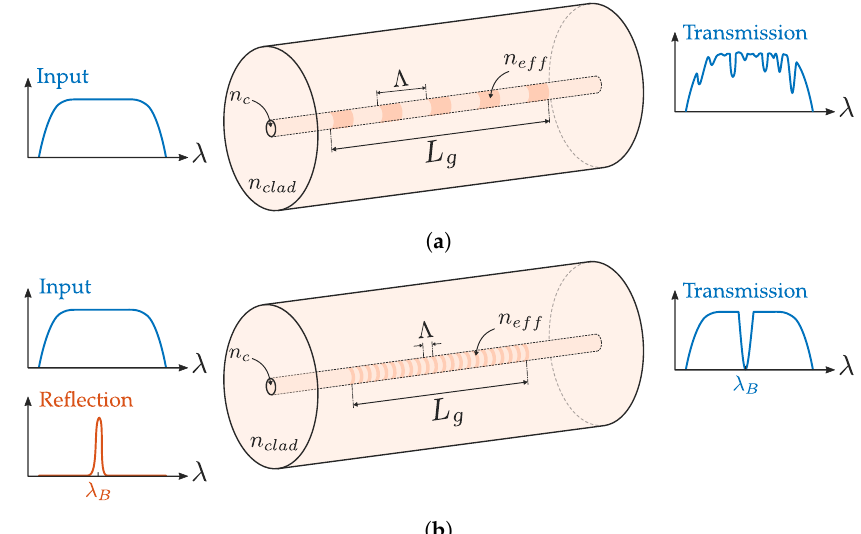
Figure 3. ( a ) Gratings with a period Λ (cid:29) λ are known as Long Period Gratings (LPG) and couple the light of fundamental mode to the cladding modes. ( b ) When the grating exhibits lower periods Λ ≤ λ , it reflects light at Bragg resonance and is known as fiber Bragg grating (FBG).